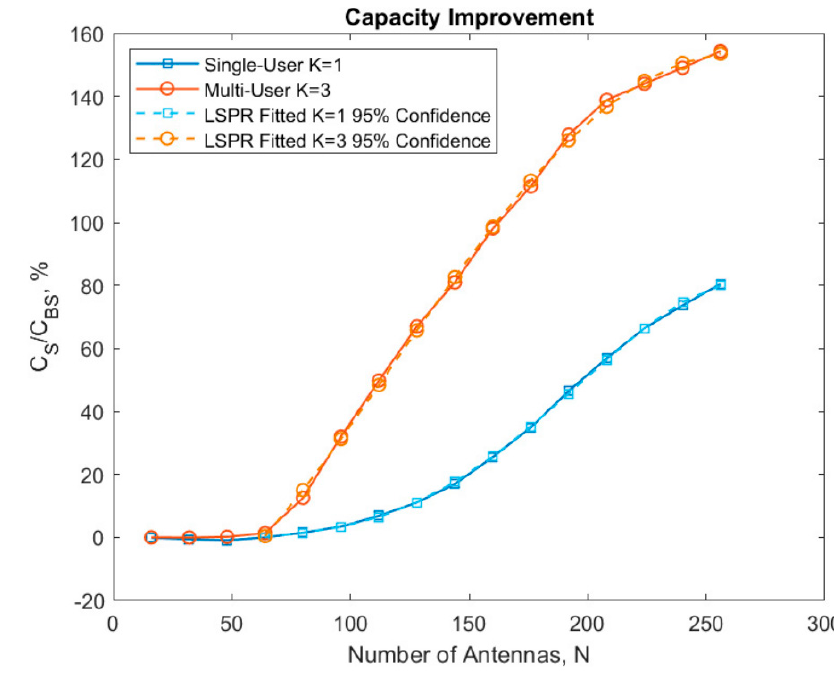
Figure 11. Improvement of capacity for fc = 73 GHz, BW = 2.5 GHz [52].